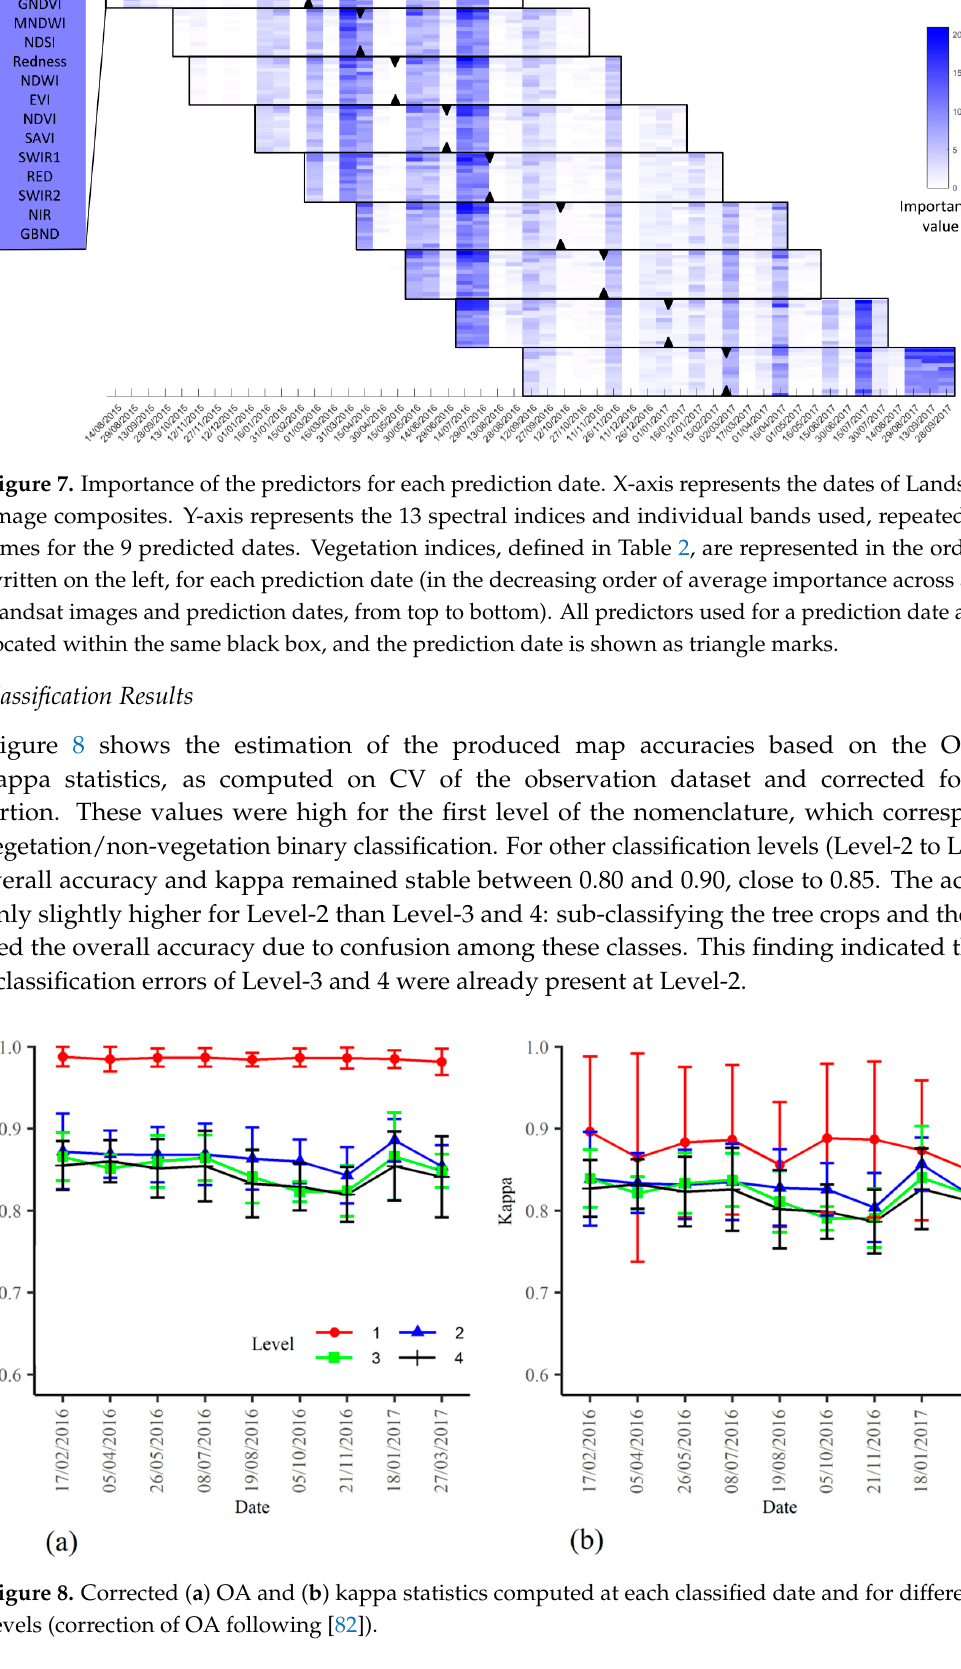
Figure 9. Classification map of the study area obtained for 18 January 2017. Pie charts are the proportion of each land cover on 26 May 2016 ( a ) and in 18 January 2017 for different regions in the